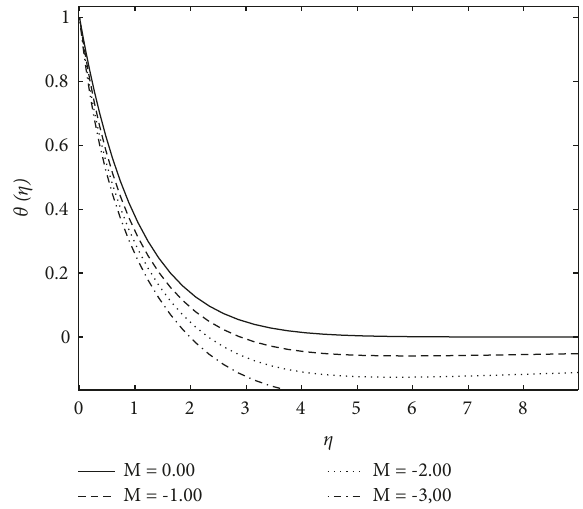
Figure 12: Change in the value of θ ( η ) for different values of M